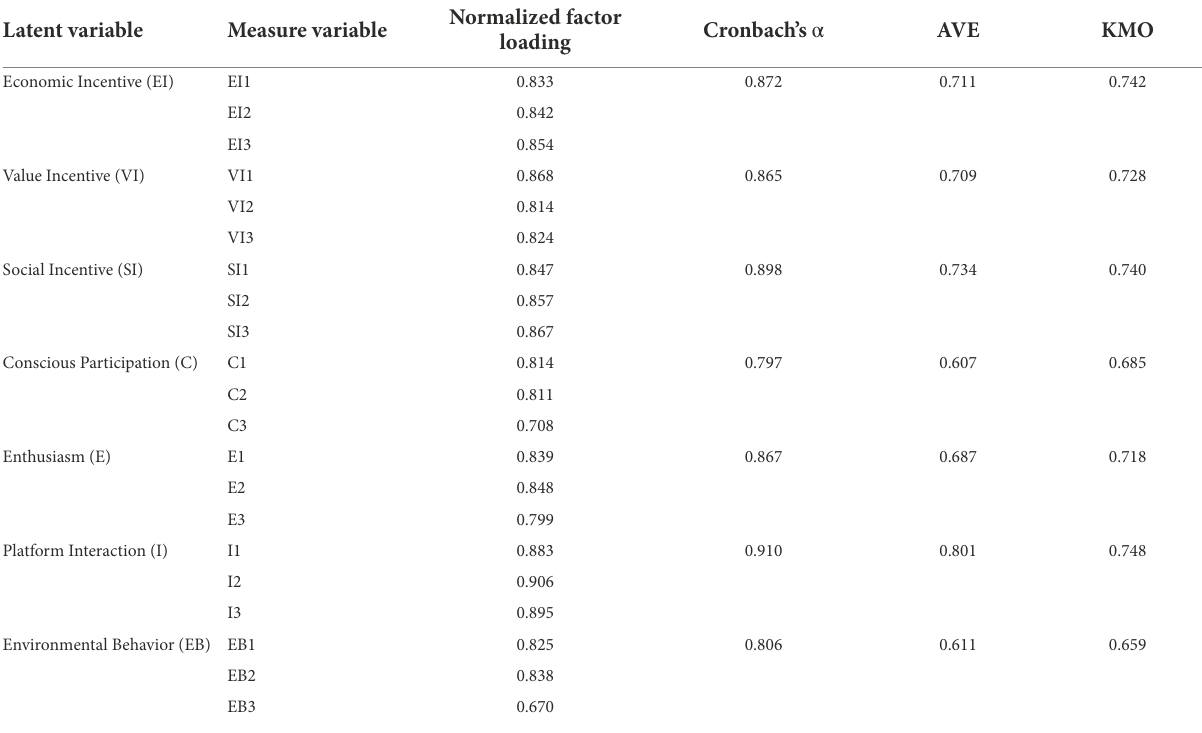
TABLE 3 Results of the confirmatory factor analysis.